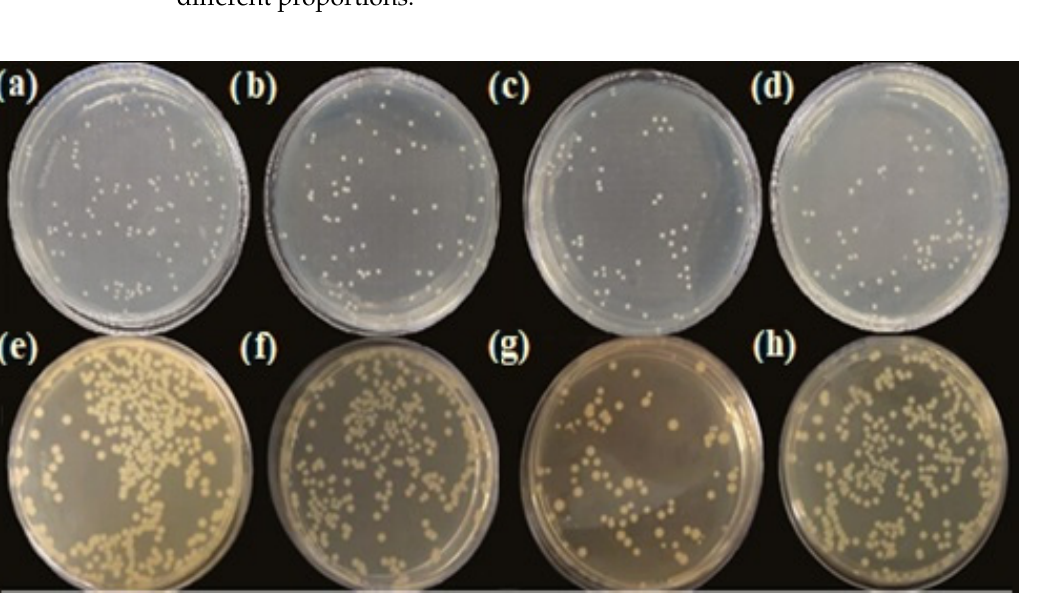
Figure 5. SEM of BCP-60, BCP-50, and BCP-40.